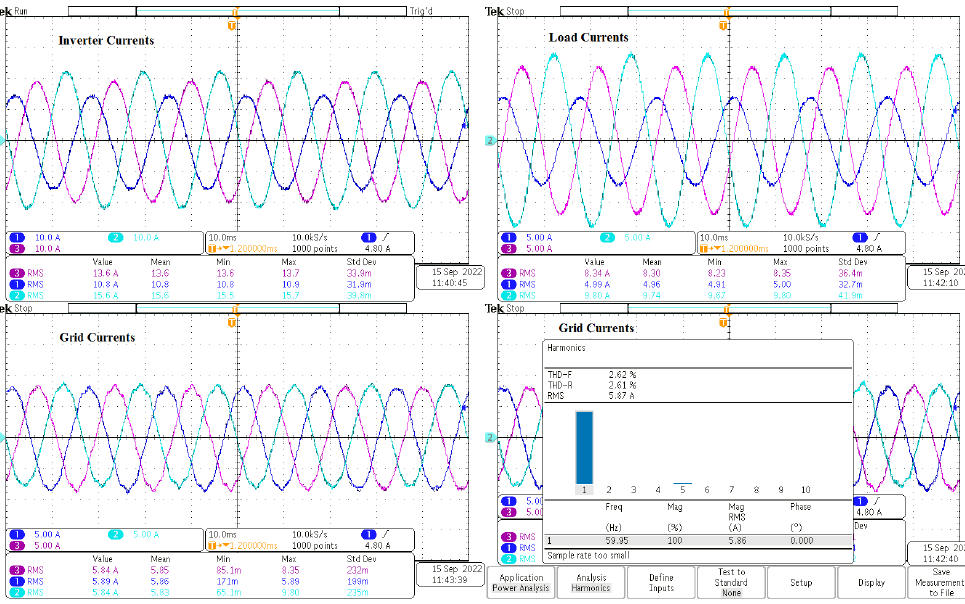
Figure 20. Hardware results using Tektronix MDO3024 oscilloscope for real power= 2 kW and reactive power = 0 var under balanced grid